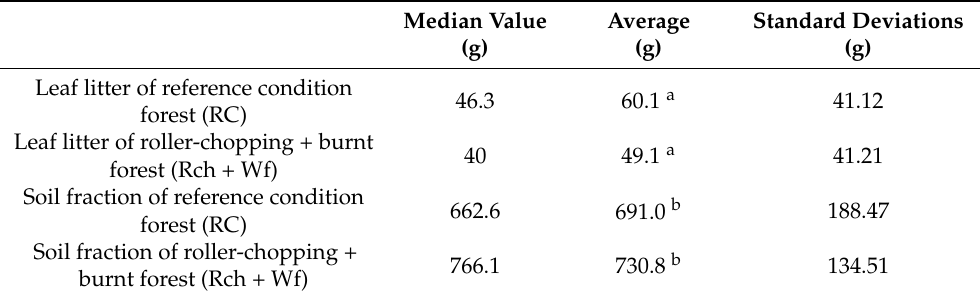
Table 4. Statistical data of weight (grams) of leaf litter and soil fractions in samples of soil seed banks from Chaco forests with different land-management types. RC = reference condition forest, Rch + Wf = rolled-chopper and burnt forest.